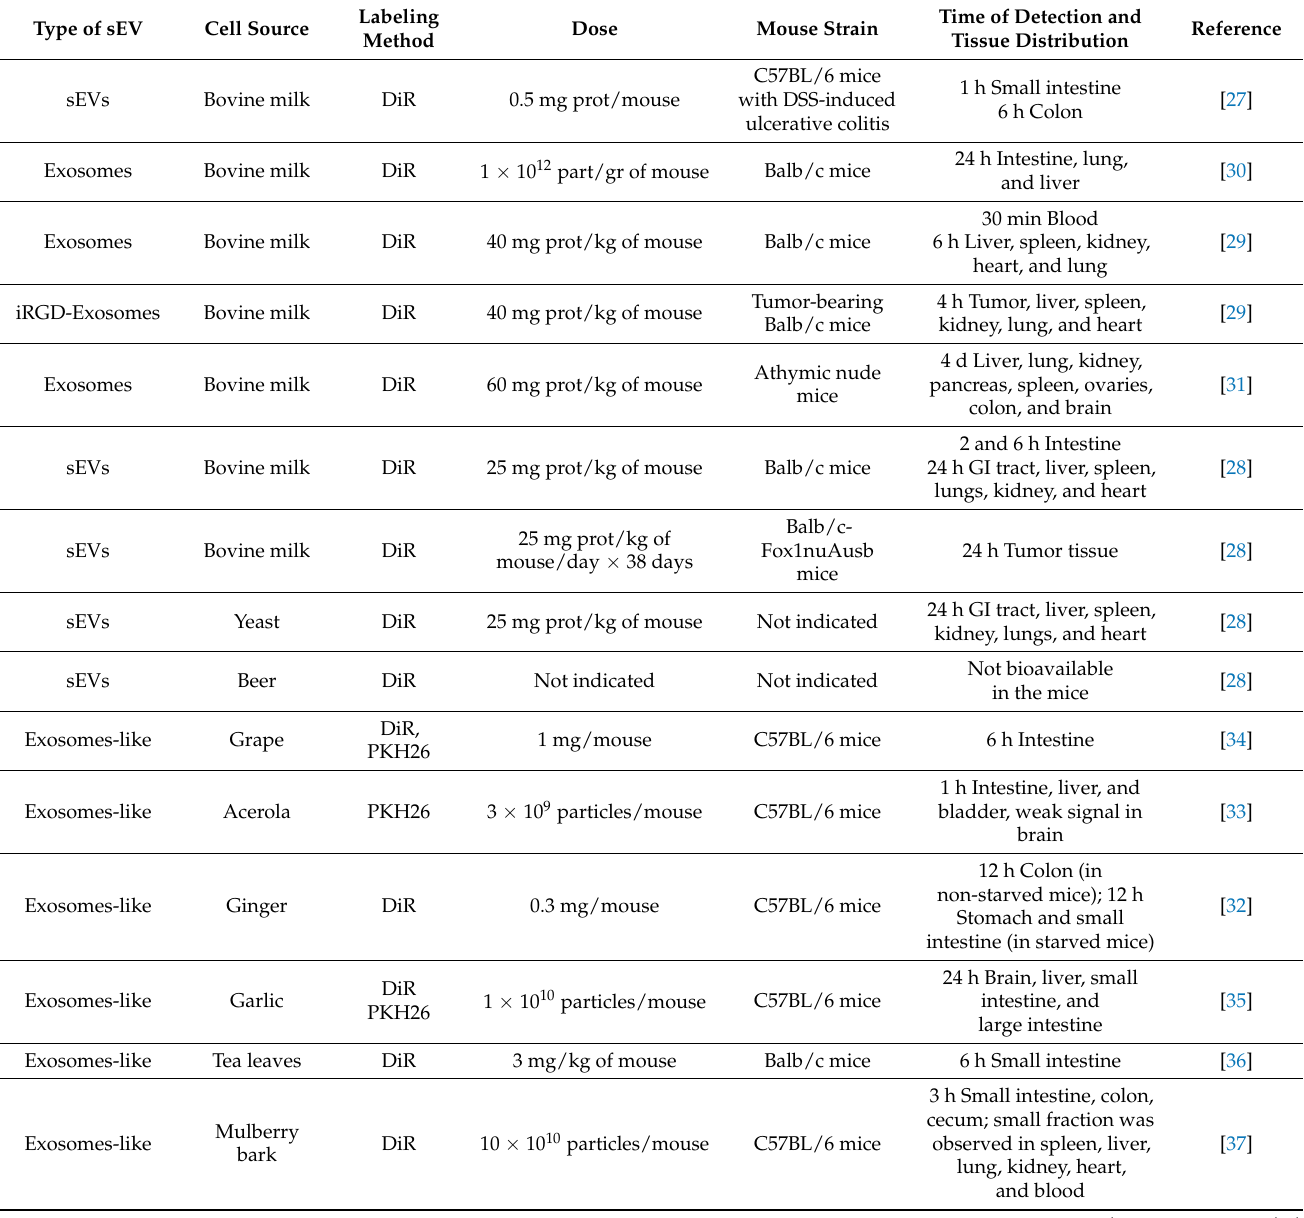
Table 1. Comparative summary of the biodistribution of orally administered